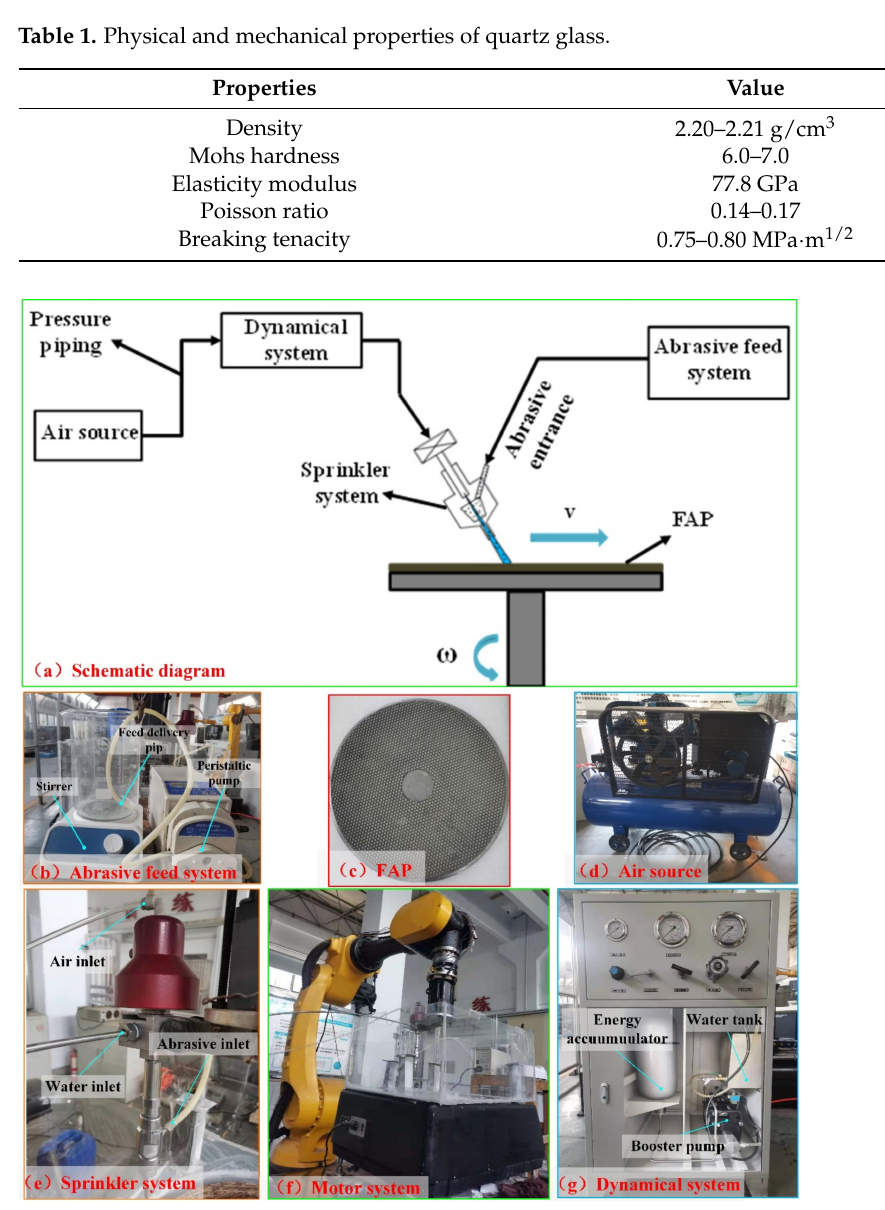
Figure 2. Principle ( a ) and physical diagram of abrasive jet dressing system ( b – g